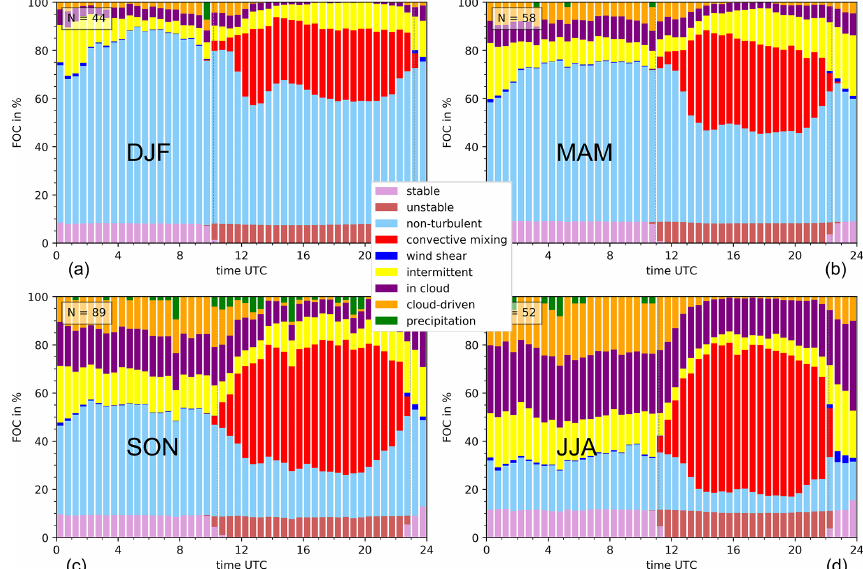
Figure 13. Diurnal course of FOC of boundary-layer classes during different seasons. Clockwise from panel (a) : austral summer (DJF), fall (MAM), winter (JJA) and spring (SON). The value of N gives the number of days analyzed.